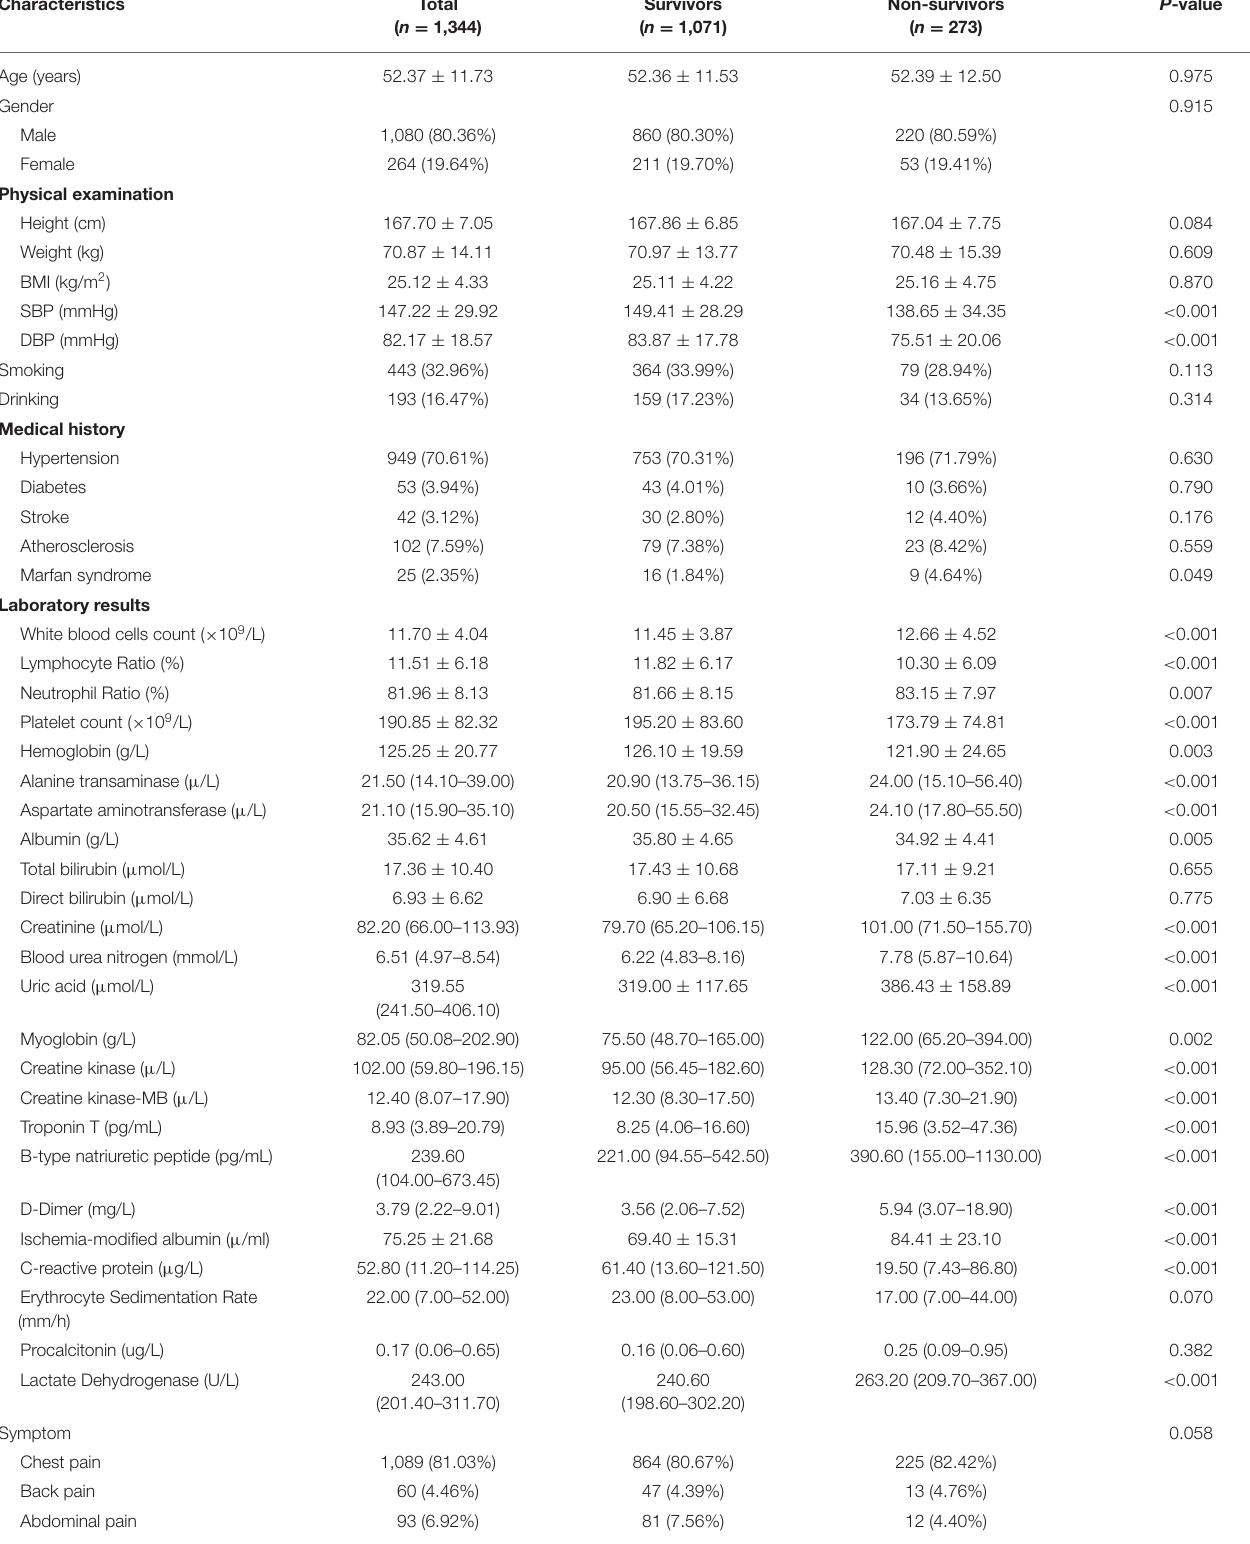
TABLE 1 | Baseline characteristics of the AAD patients.